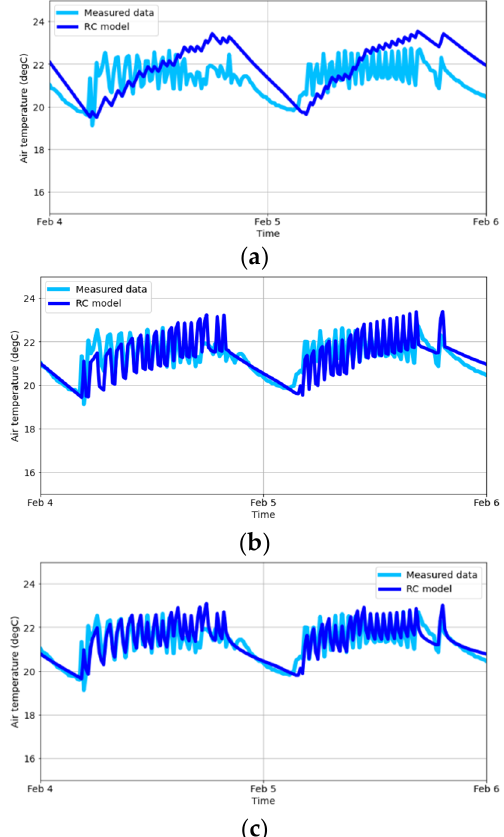
Figure 7. Calibration of RC thermal network models with measured data: ( a ) first-order, ( b ) second- order, and ( c ) third-order models.